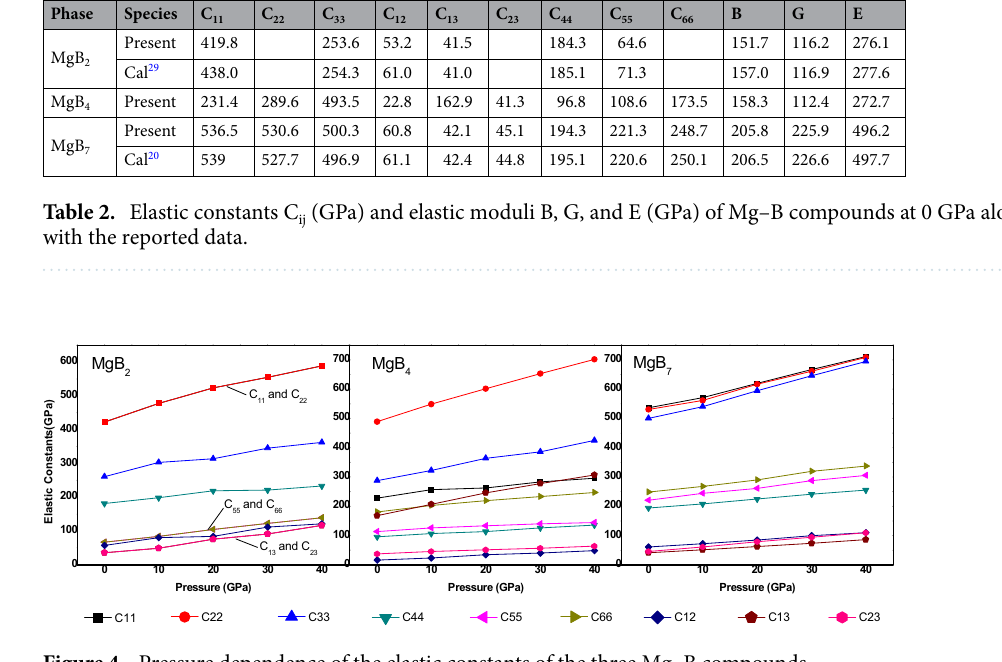
Figure 4. Pressure dependence of the elastic constants of the three Mg–B